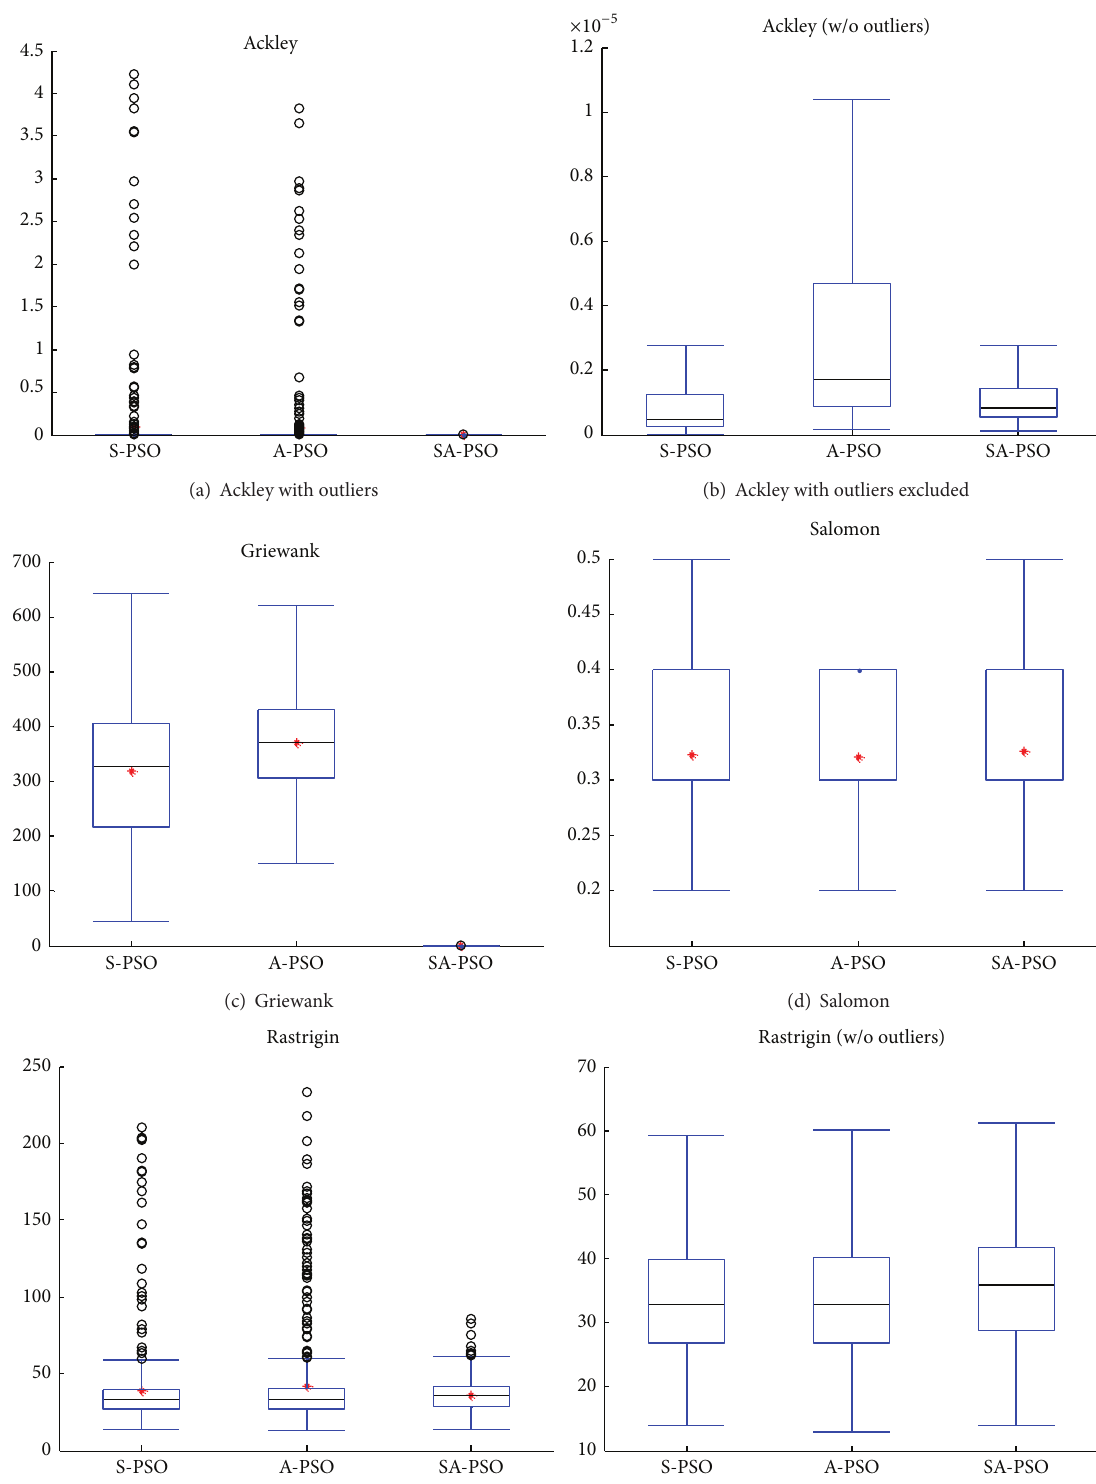
Figure 5: Results of experiments on multimodal